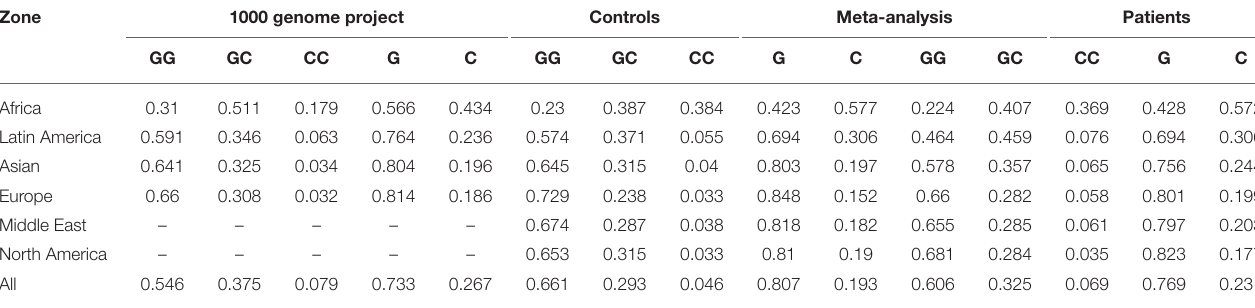
TABLE 5 | Comparison of the frequencies obtained in the present meta-analysis and those reported by the 1,000 genome project (Consortium, 2015). Zone 1000 genome project Controls Meta-analysis